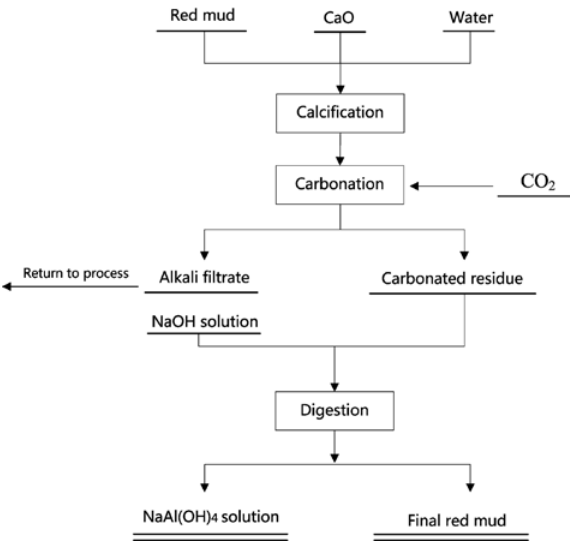
Figure 1: Flow sheet for proposed direct calcification–carbonation method.